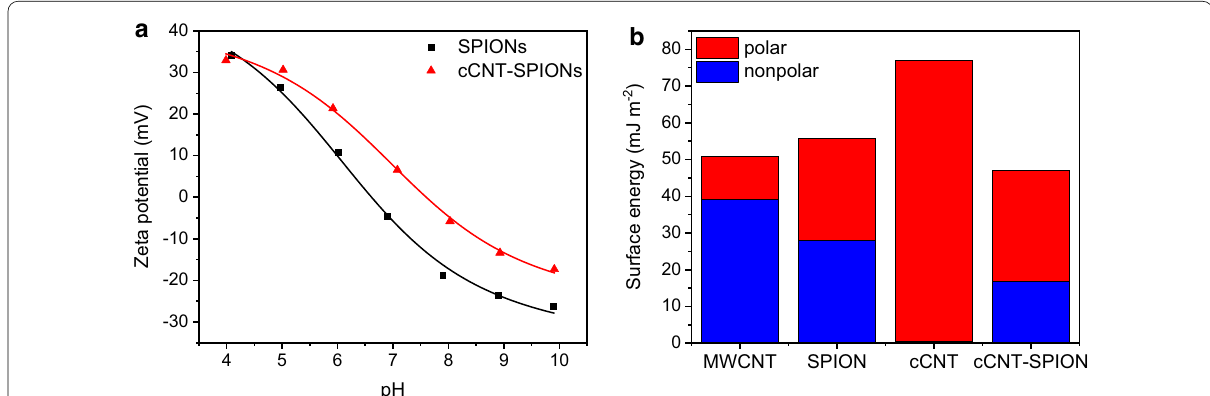
Fig. 5 Zeta potential of SPIONs and cCNT‑SPIONs from pH 4 to 10 ( a ) and surface free energy obtained from capillary rise experiments with the OWRK method ( b